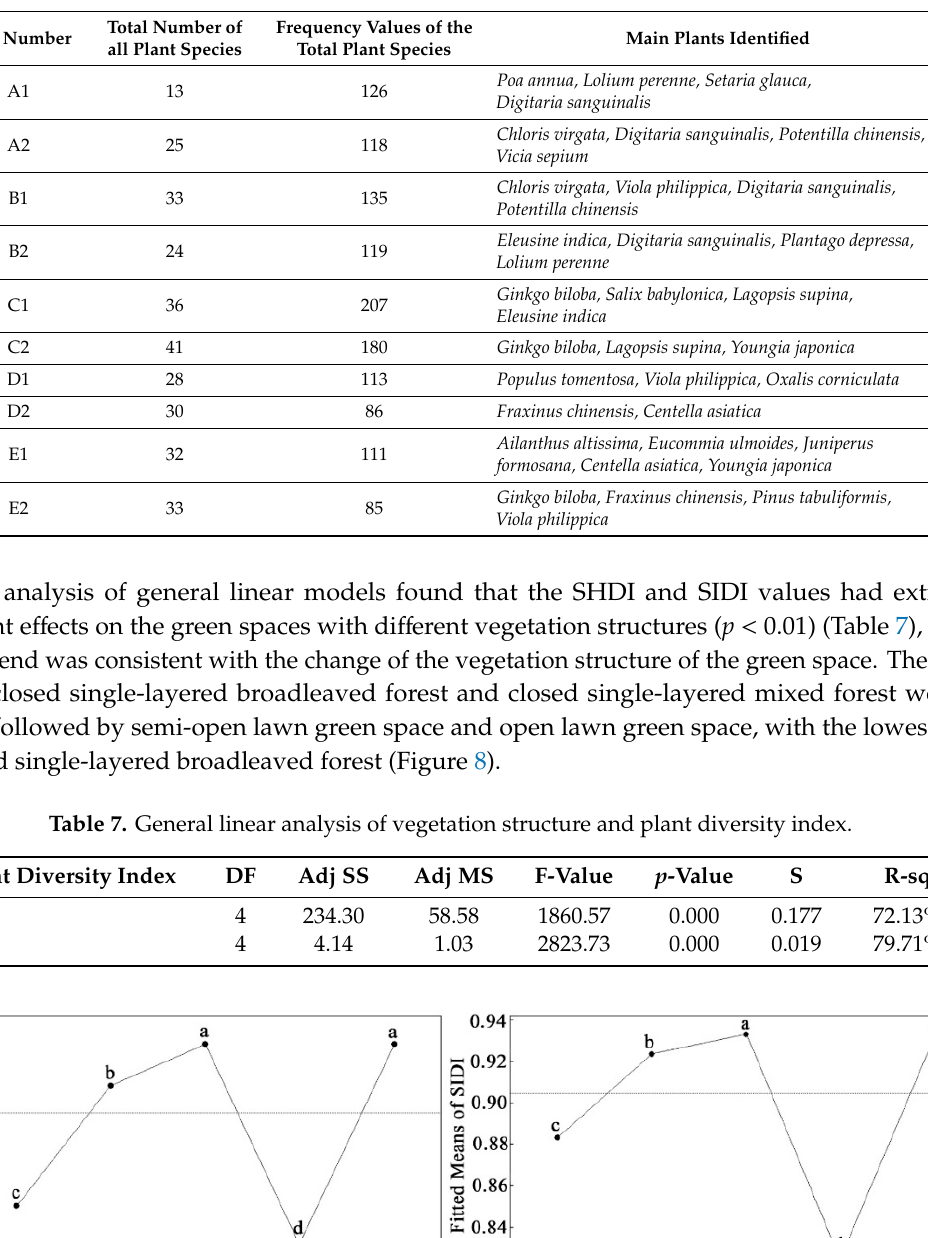
Table 6. Plant species information for each plot.